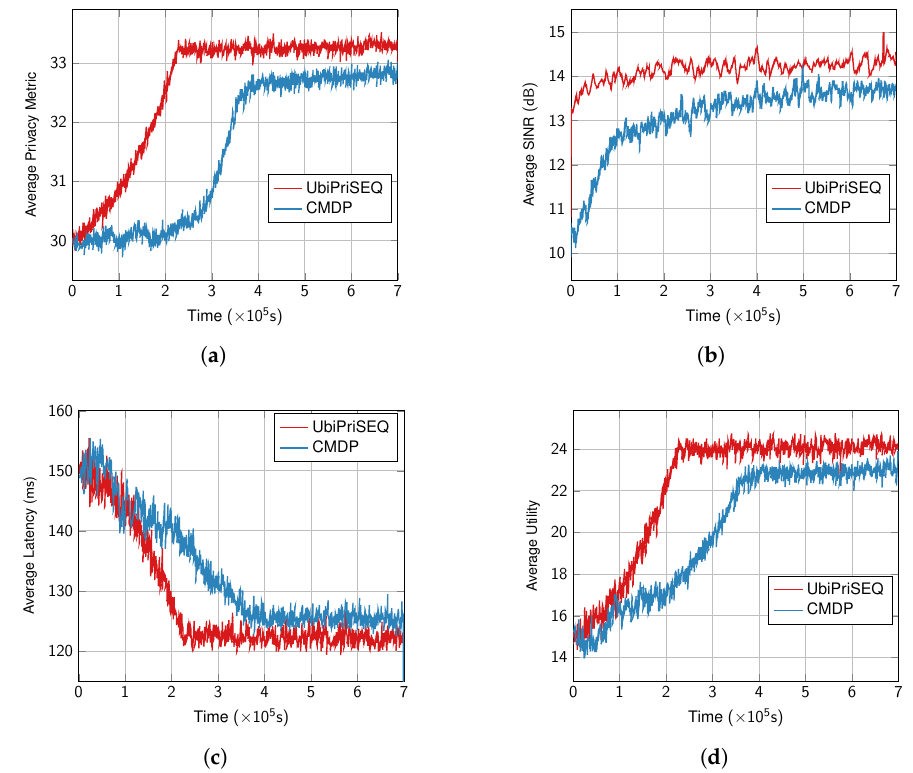
Figure 3. UbiPriSEQ: Performance vs. Time ( a ) PrivacyMetric, ( b ) SINR, ( c ) Latency, ( d )